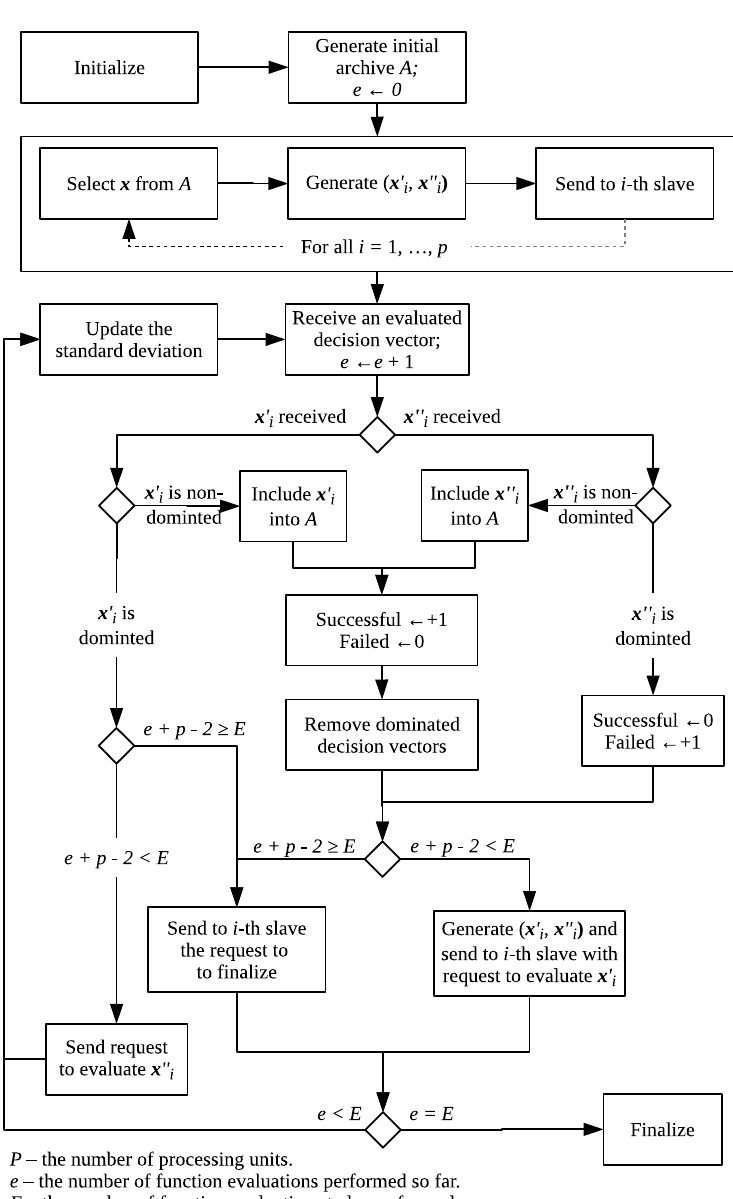
Figure 3. Scheme of ParMOSS algorithm for the master processing